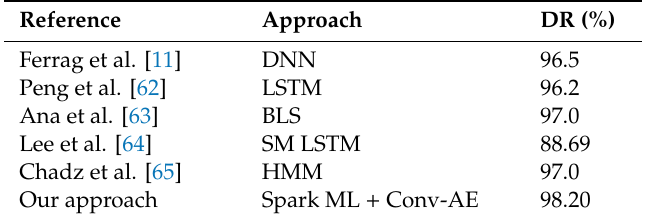
Table 8. Comparison of the proposed ID system with existing